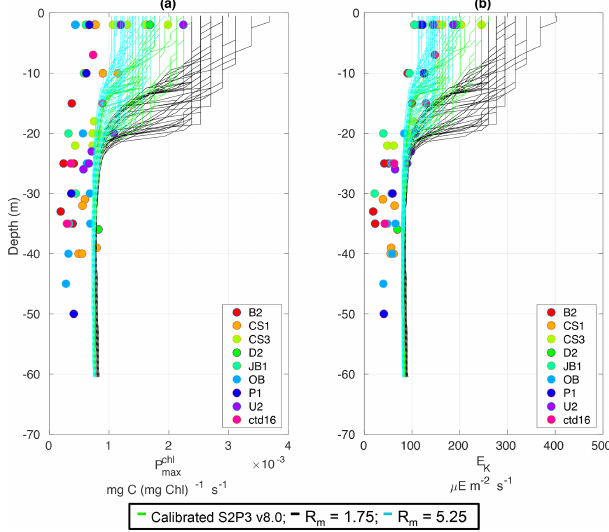
Figure C3. Observations from the cruises CD173 and JR98 in dif- ferent locations in the Celtic Sea, including the calibrated S2P3 v8.0 model (green lines), experiments R max = 1 . 75 (black lines) and R max = 5 . 25 (cyan lines) for (a) chlorophyll a specific maximum light-saturated photosynthesis rate parameter ( E k